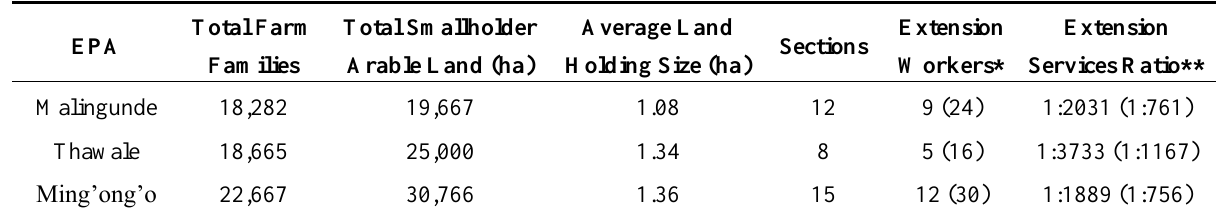
Table 1. Average land holding size for Malingunde, Thawale and Ming’ong’o